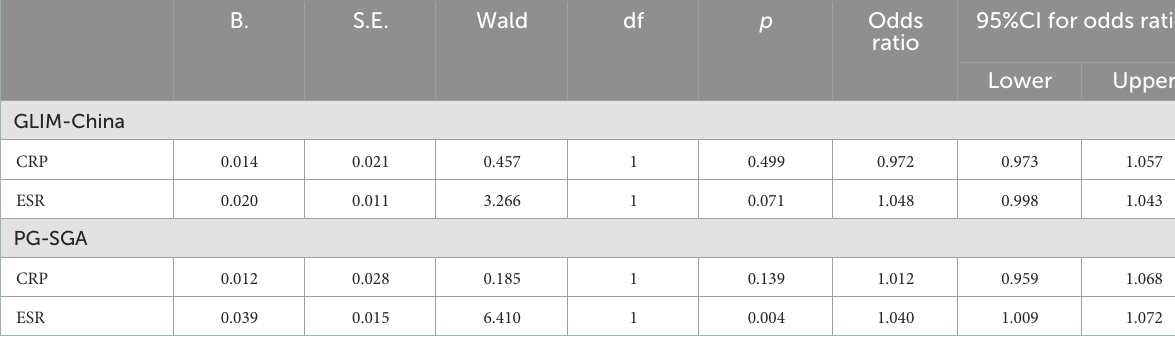
TABLE 5 Logistic analysis between CRP/ESR and GLIM-China/PG-SGA.